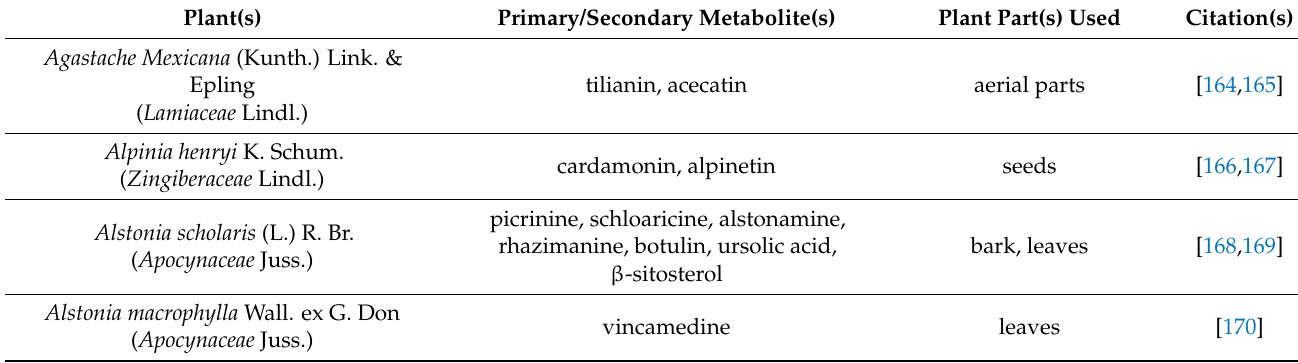
Table 5. Combination of mechanisms without a dominant